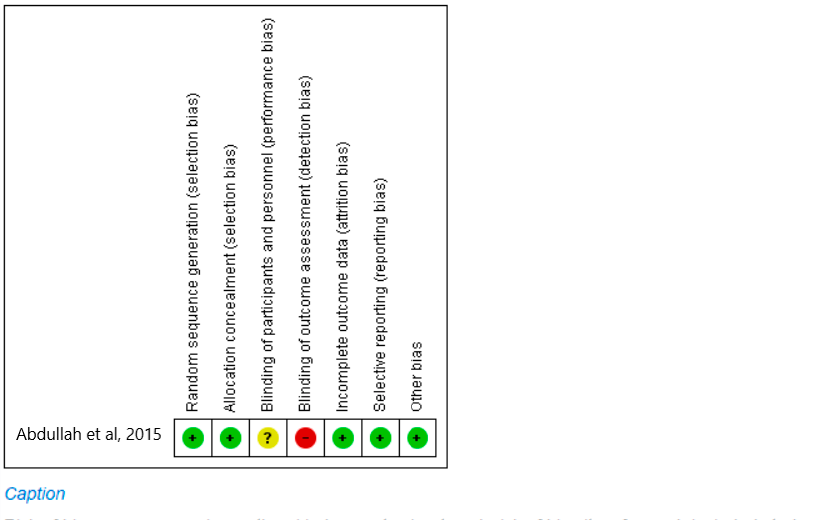
Figure 2. Risk of bias summary for included clinical study (Abdullah et al., 2015 [18]). Table 3. Risk of bias for laboratory